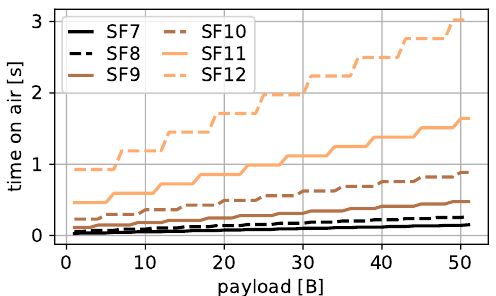
Figure 1. Payload and SF to ToA